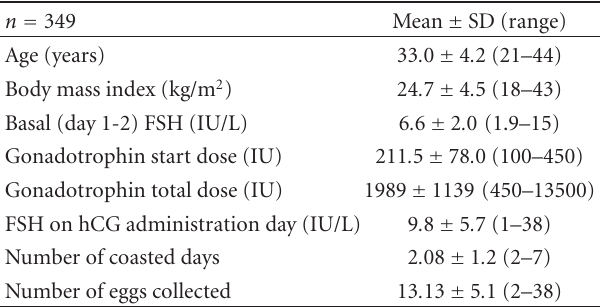
Table 1: Demographic characteristics and variables of the study population. n =